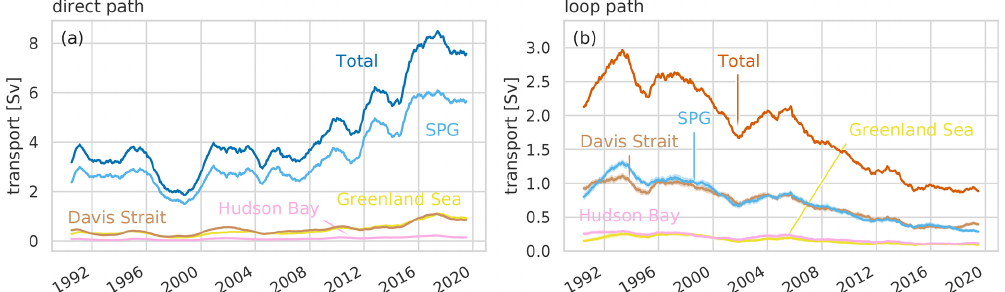
Figure 10. Source regions upstream of the Labrador Sea outflow. Quantifying contributions from sources upstream of the Labrador Sea outflow for the direct path (a) and the loop path (b) . Upper-layer inflow to the Labrador Sea comes from Hudson Bay (pink), Davis Strait (brown), and the West Greenland Current. The West Greenland Current is further divided here into water from the Greenland Sea (yellow) and recirculating SPG origin water (light blue). There is little change in the proportions of water from different upstream sources forming the different paths (loop or direct). Overall, the increased contribution of the direct path (a) is reflected in an increase in the total volume of recirculating SPG transport and a small increase in the total contribution from the Greenland Sea. Particles from Hudson Bay, Davis Strait, and the Greenland Sea have come directly from those regions; SPG origin waters are circulating in the subpolar gyre and have previously crossed northwards across OSNAP E